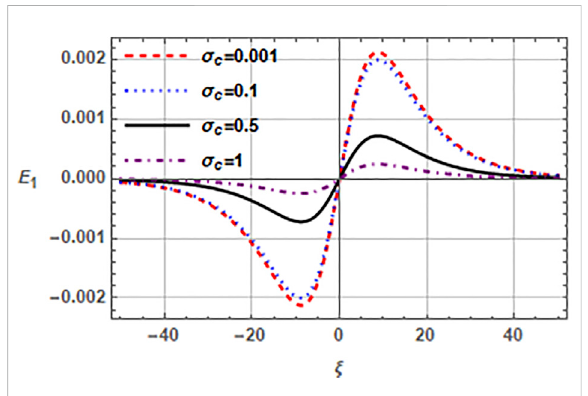
FIGURE 5 Variation of normalized electric fi eld E 1 ( ξ , τ ) of EASWs against thenormalized ξ versustheratioofdensities β (= n h 0 / n b 0 ).Here q = 2.5, r = 0.4, n h 0 = 2 cm − 3 , n c 0 = 0.5 cm − 3 , σ c = 0.001, σ b = 0.01, v b 0 = 0.1 and τ = 0.